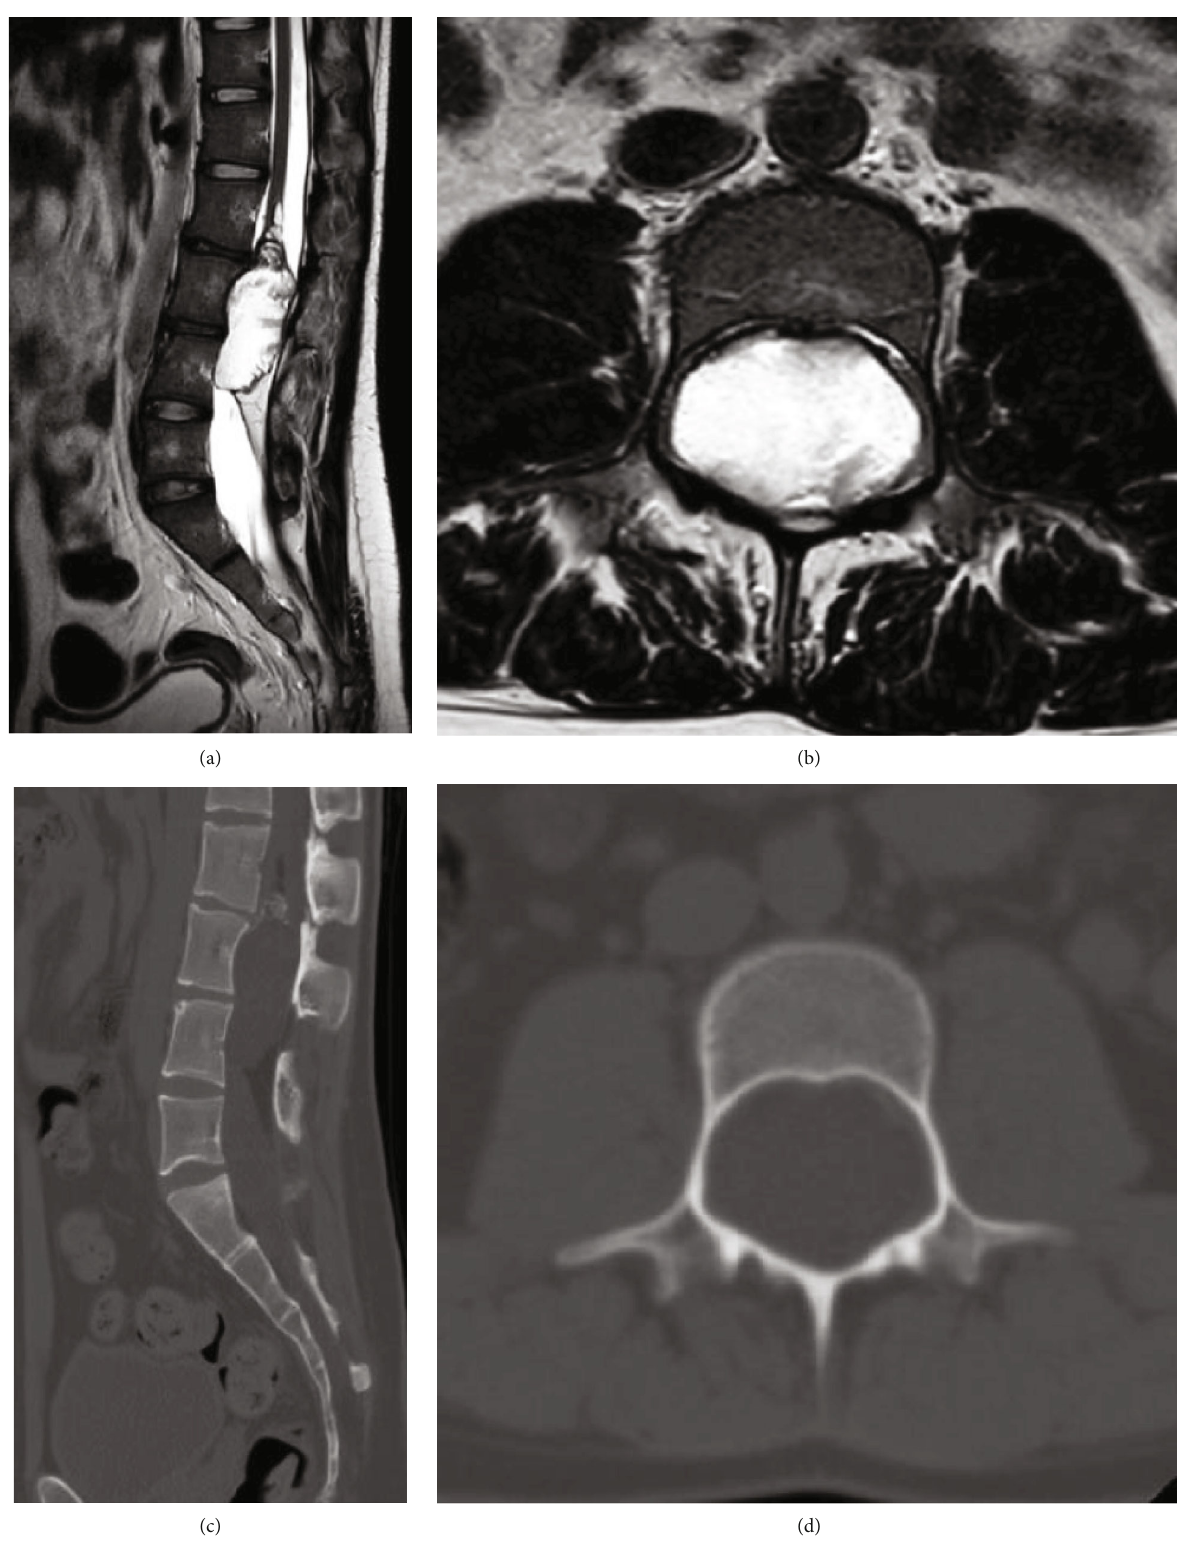
Figure 1: (a) Sagittal T2 MRI image showing hyperintense lesion with scalloping of the posterior aspect of the L3 vertebra. (b) Axial T2 MRI image showing heterogeneous hyperintense lesion causing expansion of the vertebral canal and narrowing of the pedicle bilaterally. (c) Midline sagittal CT image showing scalloping of the vertebra with lesions suggesting calci fi cation at the top of the expansile lesion in the L3 level. (d) Axial CT image at the L3 vertebra level reinforcing the evidence of narrowing of the pedicles bilaterally, scalloping of the posterior vertebral body, and expansion of the vertebral